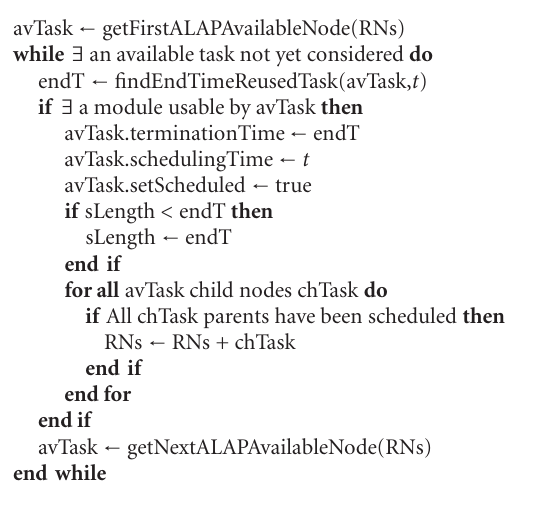
Algorithm 2: Reuse function pseudocode.